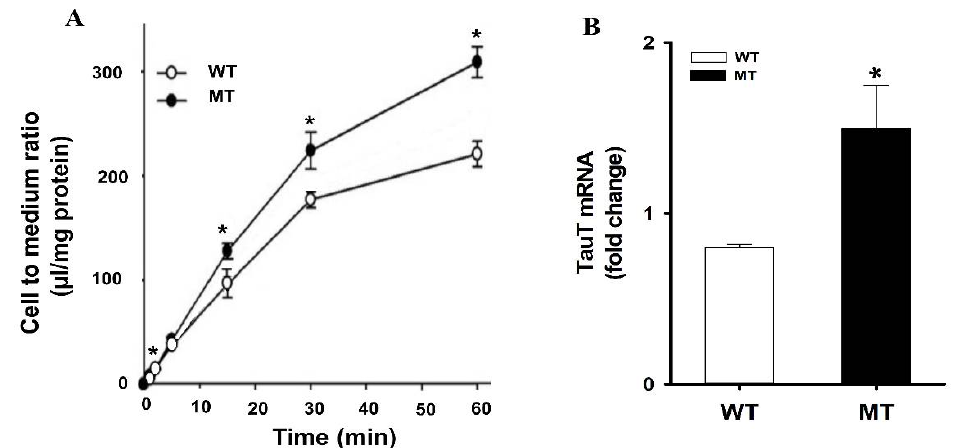
Figure 1. Data was retrieved and analyzed from the earlier published study by Jung et al., 2013, in ALS cells [21]. ( A ) Uptake of [ 3 H]taurine in a time dependent manner. Uptake was carried at temperature 37°C. ( B ) Relative expressions of TauT transporter in ALS model cell lines. mRNA expression levels were determined using quantitative RT-PCR analysis and normalized to the internal control GAPDH in ALS model cell lines. Each value represents the mean ± SEM. ( n = 3–4). * p < 0.05 indicates a significant difference with respect to the WT control.